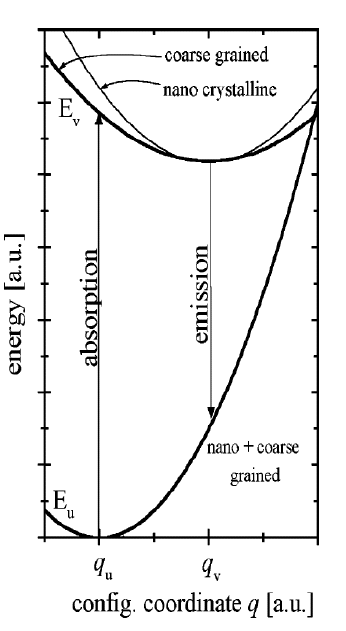
Figure 27 . Effects of reducing the particle size